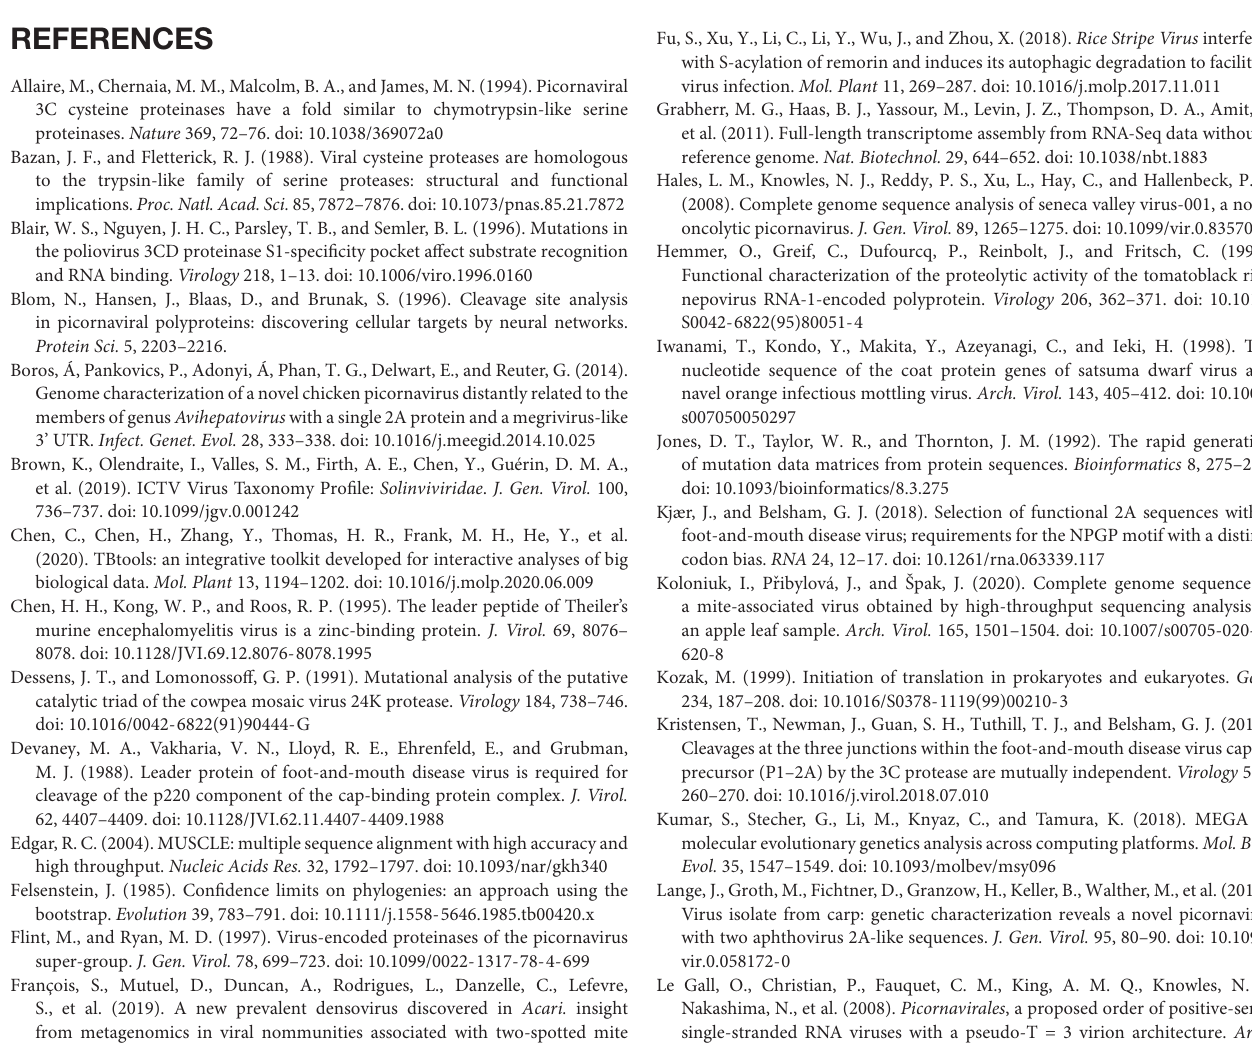
Supplementary Figure 4 | The original images of Figures 4F (A) and 4H (B) . Supplementary Figure 5 | Sequence alignment of 3Cpros from rice curl dwarf-associated picornavirus (RCDaV) and the seven unclassified picornaviruses. The core motifs of these 3Cpros are highlighted by red box. Supplementary Table 1 | All primers used in this study. Supplementary Table 2 | Details of the expressed genes and their vectors. Supplementary Table 3 | Viruses used in the phylogenetic analyses. Supplementary Table 4 | The BLASTp search using the RNA_dep_RNAP domain of rice curl dwarf-associated picornavirus (RCDaV). Supplementary Table 5 | Pairwise sequence comparison of rice curl dwarf-associated picornavirus (RCDaV) with other viruses in the